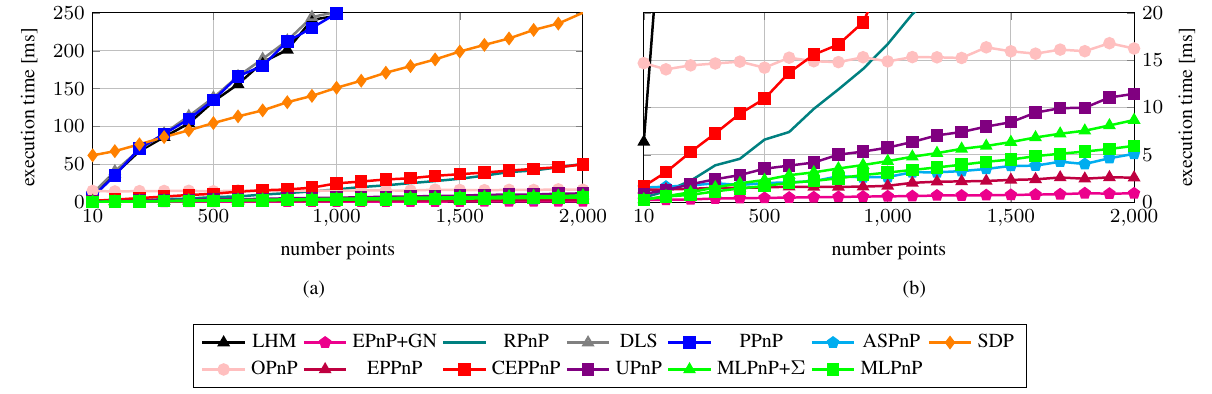
Figure 2. Runtime. (a) All methods. (b) Zoom to the fastest methods. CEPPnP and MLPnP+ Σ incorporate measurement uncertainty. All other algorithms assume equally well measured image points.